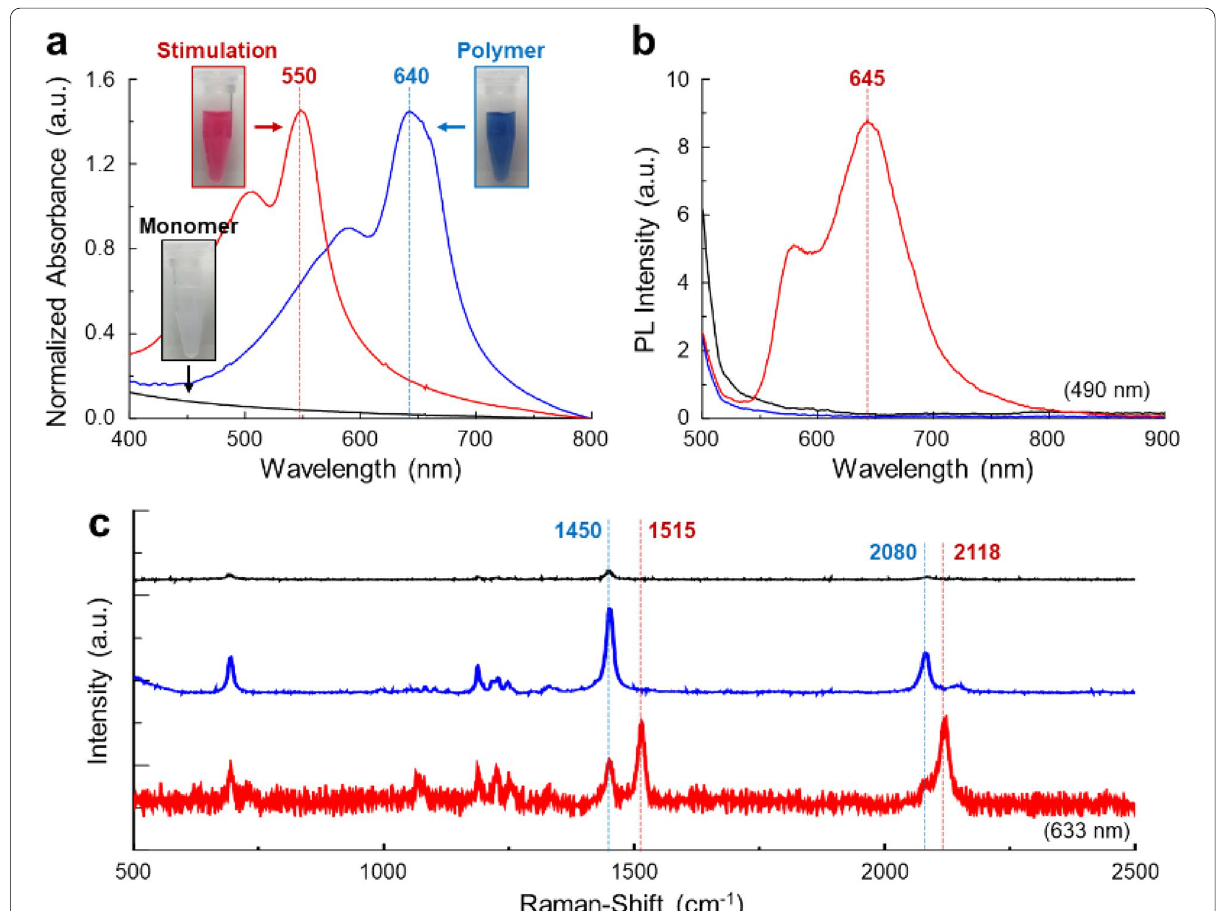
Fig. 2 a Visible, b PL, and c Raman-shift spectra of TCDA/silica. Inset images of a : TCDA/silica with phases in deionized water. (Black line and box: monomeric phase, blue line and box: polymeric phase, and red line and box: thermal stimulated phase (~ 110